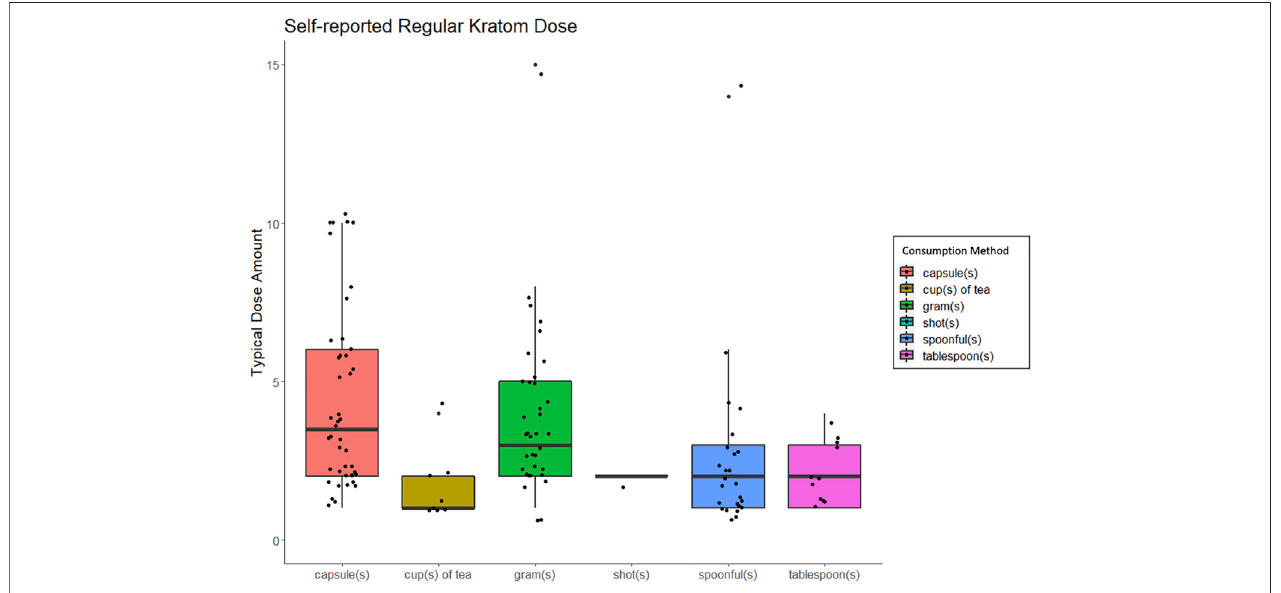
FIGURE 1 | Box and whisker plots displaing people's self-reported "regular" or "typical" kratom dose, broken down by method of kratom